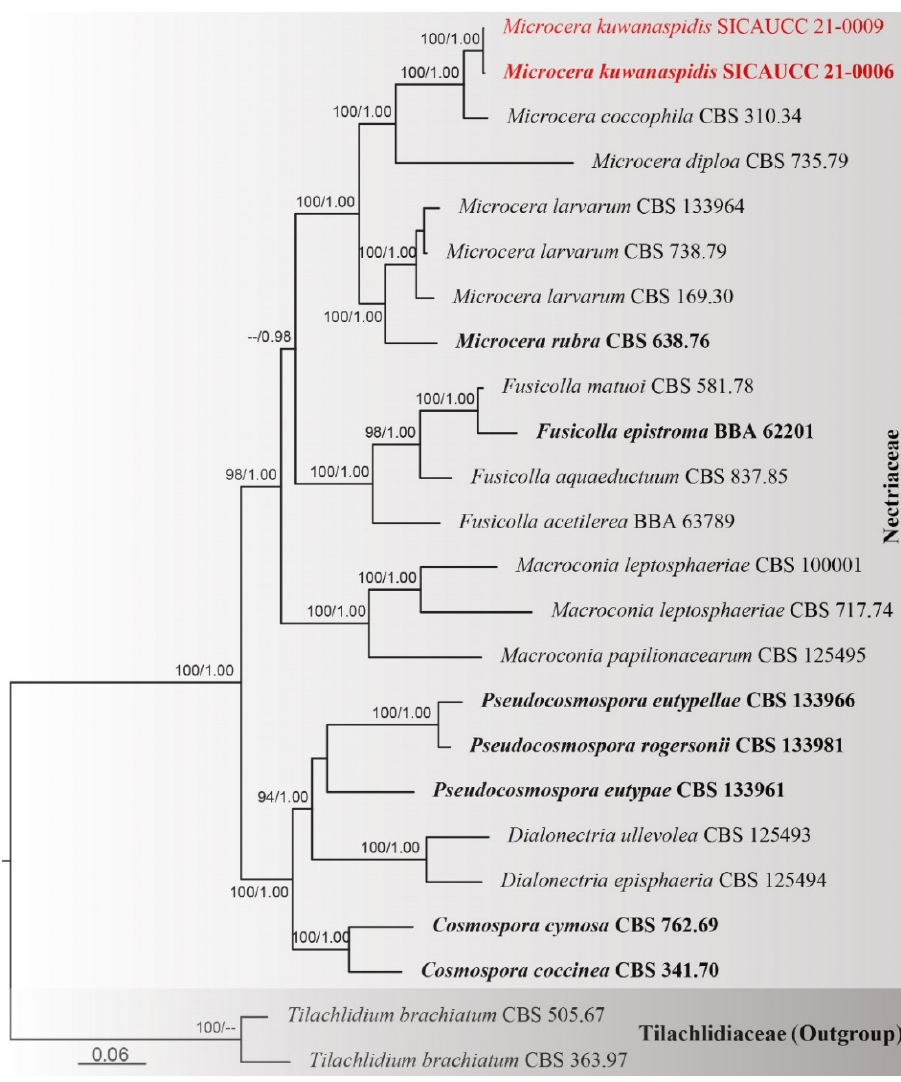
Figure 2. Phylogram generated from RAxML analysis based on combined ITS, LSU, tef1- α , rpb1 , rpb2 , acl1 , act , tub2 , cmdA , and his3 sequence data of Microcera isolates. Bootstrap support values for maximum likelihood (ML, left ) higher than 70% and Bayesian posterior probabilities (BYPP, right ) equal to or greater than 0.95 are indicated at the nodes respectively. The sequences from ex-type strains are in bold. The newly generated sequence is in red bold.